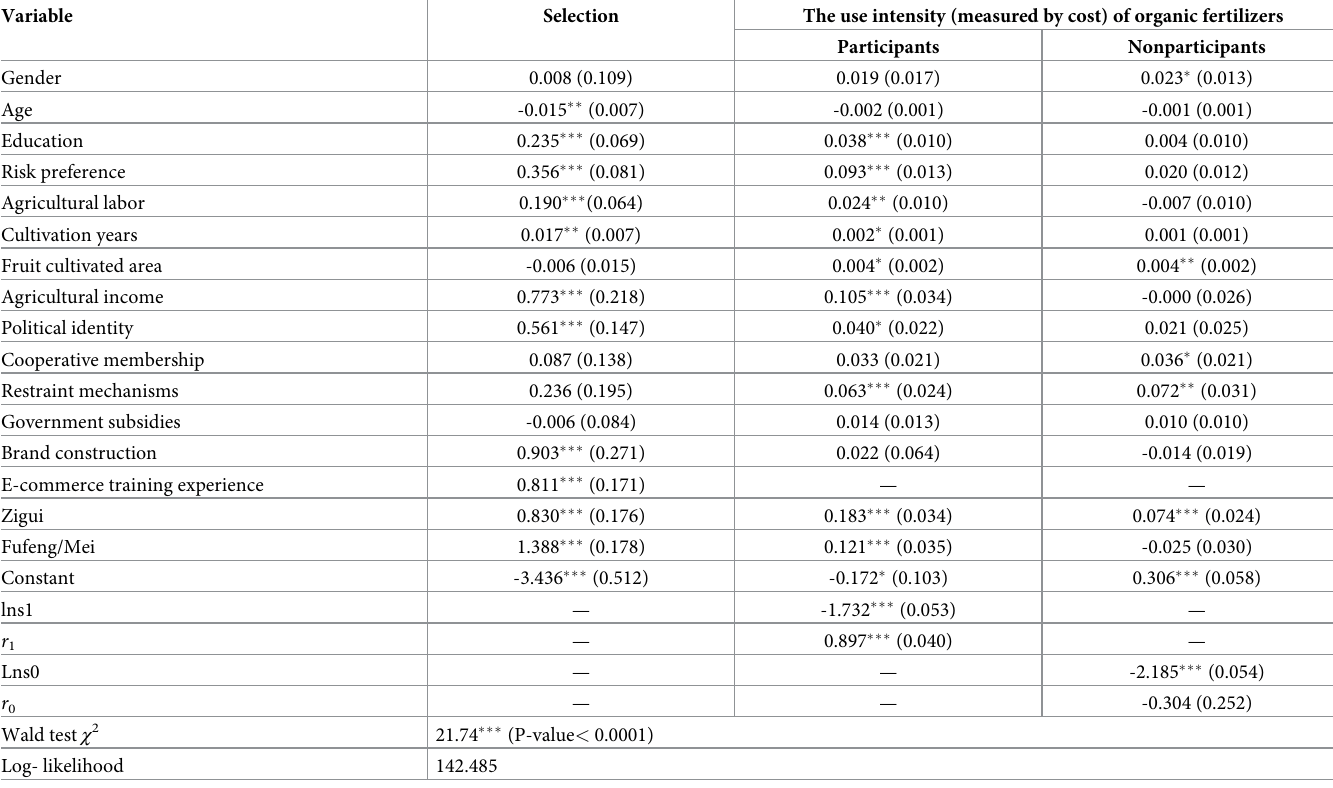
Table 4. Determinants of e-commerce participation and determinants of the use intensity (measured by cost) of organic fertilizers.